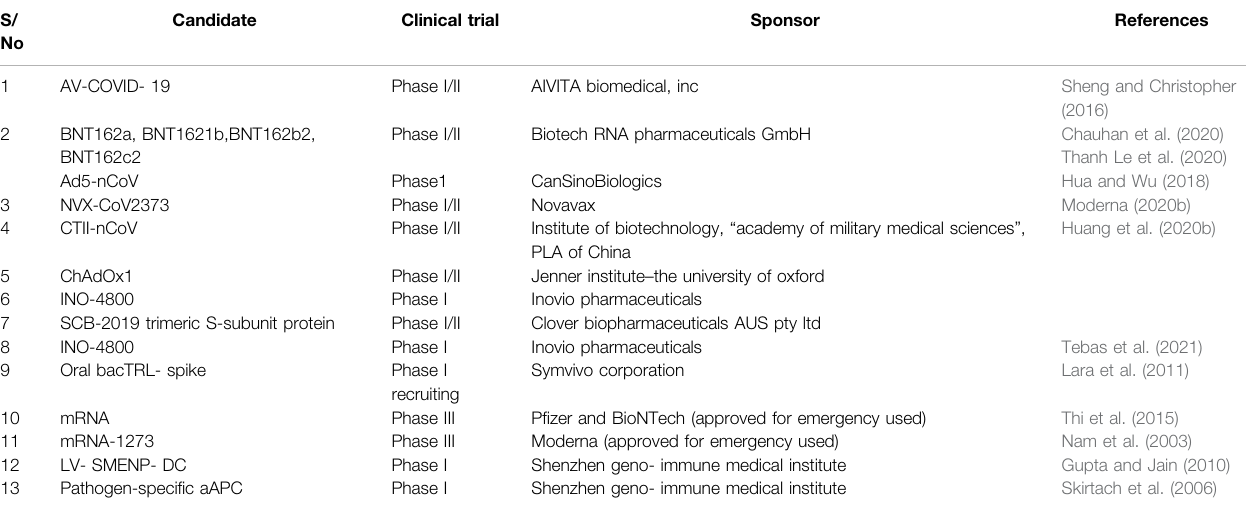
TABLE 4 | Status of some nanomedicine and vaccines in a clinical trial against